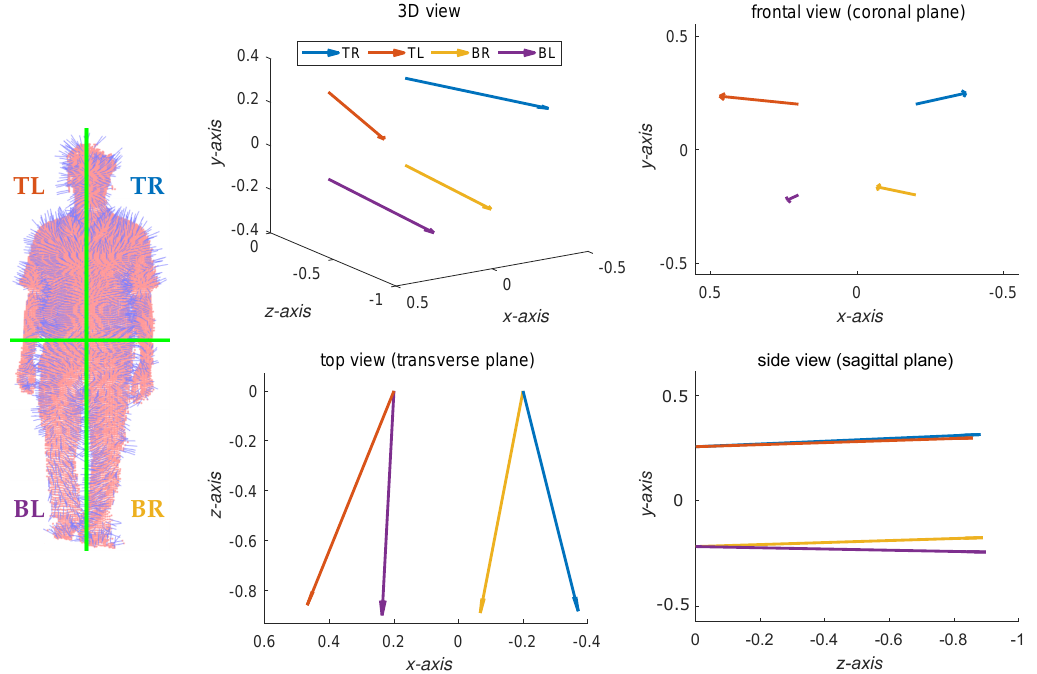
Figure 3. The separation applied on each cloud of normal vectors and the corresponding result of region-based accumulation. The frontal, side and top views are to provide an easy understanding for Section